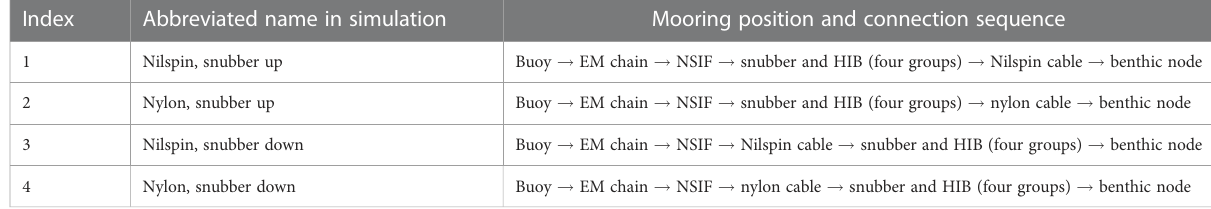
TABLE 6 Location of each component in the mooring